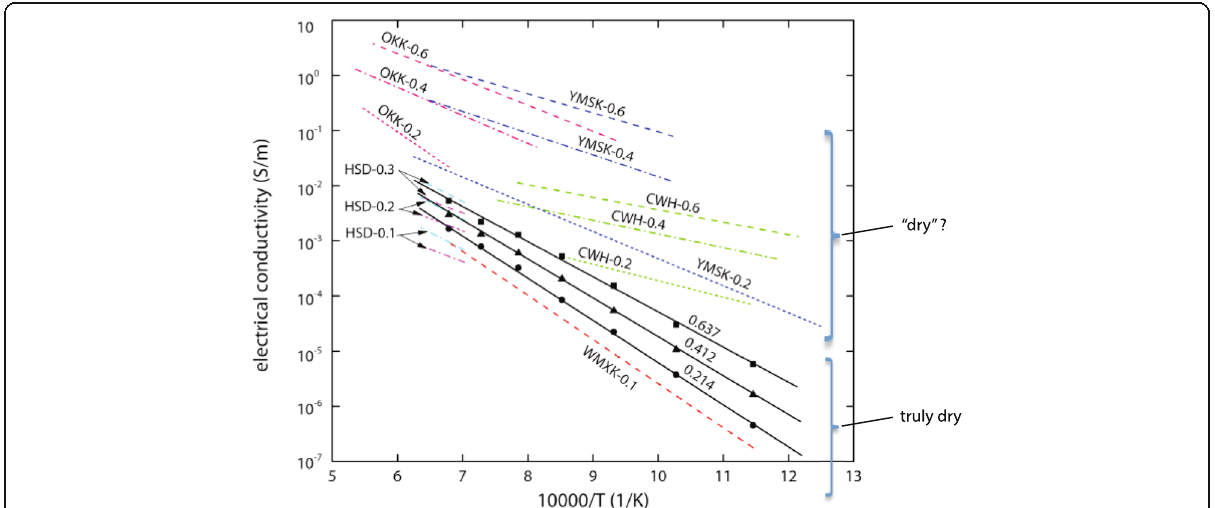
Fig. 4 Electrical conductivity of nominally “ dry ” olivine with different FeO (Mg#) content. Results shown as “ truly dry ” are those at room pressure (Constable et al. 1992; Hirsch et al. 1993) and at high pressure by (Dai and Karato 2014c) (shown by solid symbols and solid lines) where the water content of the sample was measured and shown to be small (less than 10 ppm wt). Results shown by “ dry? ” (Cemi č et al. 1980; Omura et al. 1989; Yoshino et al. 2012) are the results at high pressures but the water content of their samples was not measured. The results from these high-pressure studies show much higher electrical conductivity than those of truly dry samples. The most likely reason is the presence of some water (hydrogen) in their samples. OKK: Omura et al. (1989). YMSK: Yoshino et al. (2012). CWH: Cemi č et al. (1980). HSD: Hirsch et al. (1993). WMXK: Wang et al. (2006)